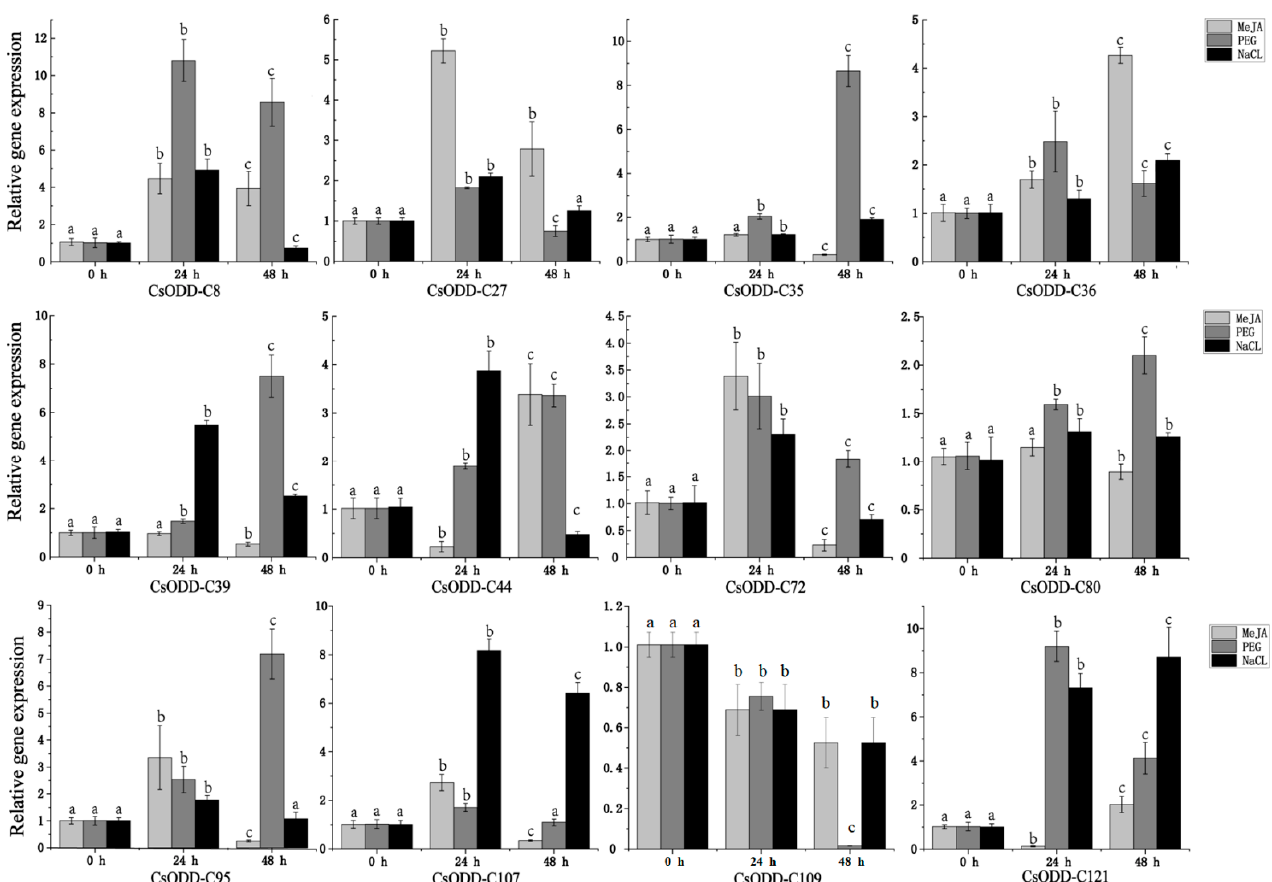
Figure 9. Expression profiles of twelve candidate Cs2ODD − C genes in C. sinensis under MeJA, PEG, and NaCl treatments. Different lower-case letters indicate a significant difference between the treated (24 h and 48 h) and untreated (0 h) samples ( p < 0.05).